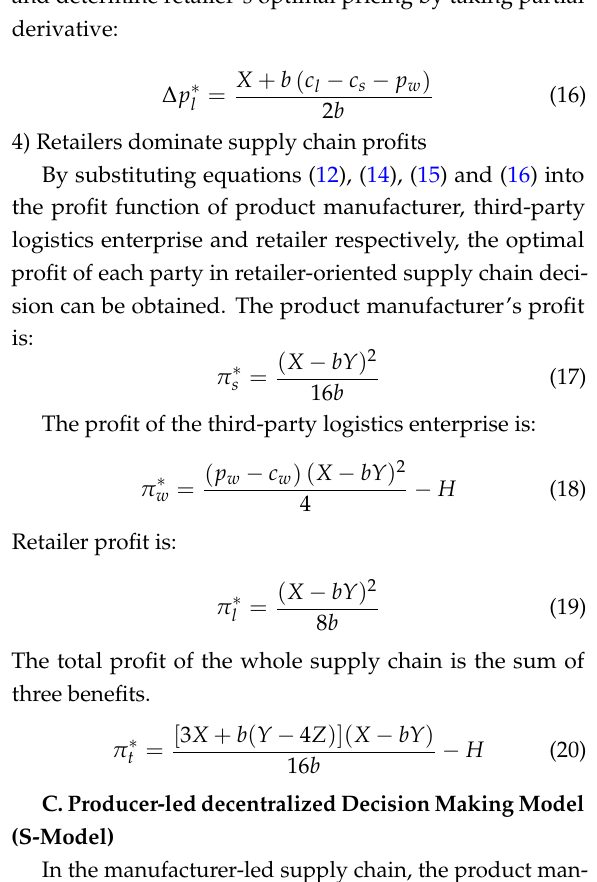
Third party logistics profit